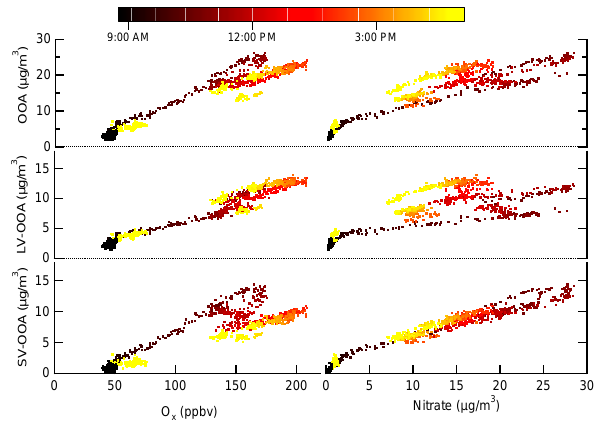
Fig. 5. Correlation of total OOA, LV-OOA and SV-OOA with O x and aerosol nitrate on 11 and 12 March 2006 at PTP (colored by time of